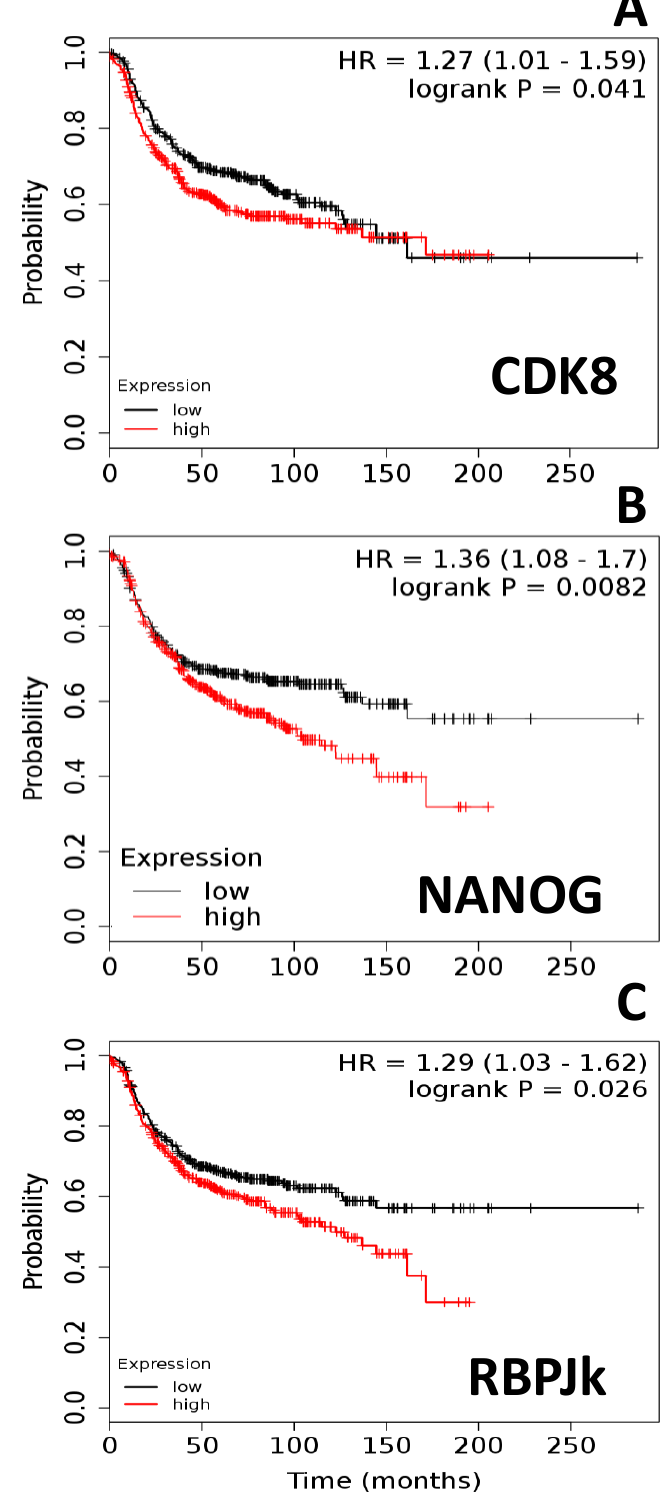
Figure 2. Expression of leptin-targeted gene mRNA reduces survival of ER-negative breast cancer patients (BCER − ). Survival curves of patients ( n = 801) with low and high expression of ( A ) CDK8, ( B ) NANOG, and ( C ) RBP-Jk. Kaplan–Meier survival plots were calculated using data from the Cancer Genome Atlas (TCGA) [18–21]. Graphs depict relapse-free survival. Patients surviving beyond the timeline threshold (20 years and 10 months) were censored instead of excluded. Hazard ratio (HR) range and p- values (logrank P) were obtained for the BCER − patients using Kmplot.com software [46].